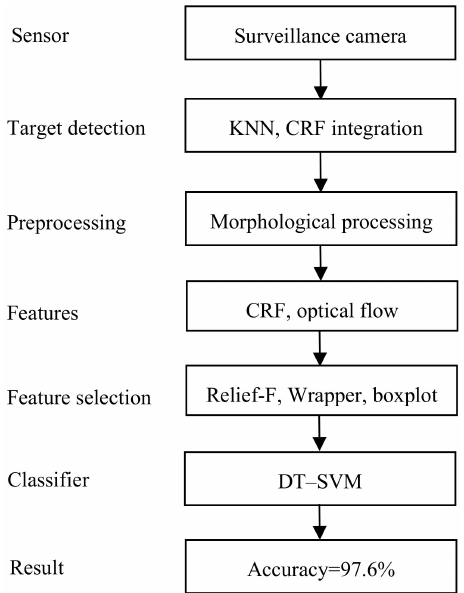
Figure 2. Flow chart of the proposed violence detection method (KNN, K-Nearest Neighbors; CRF, circumscribed rectangular frame; and DT–SVM, Decision Tree–Support Vector